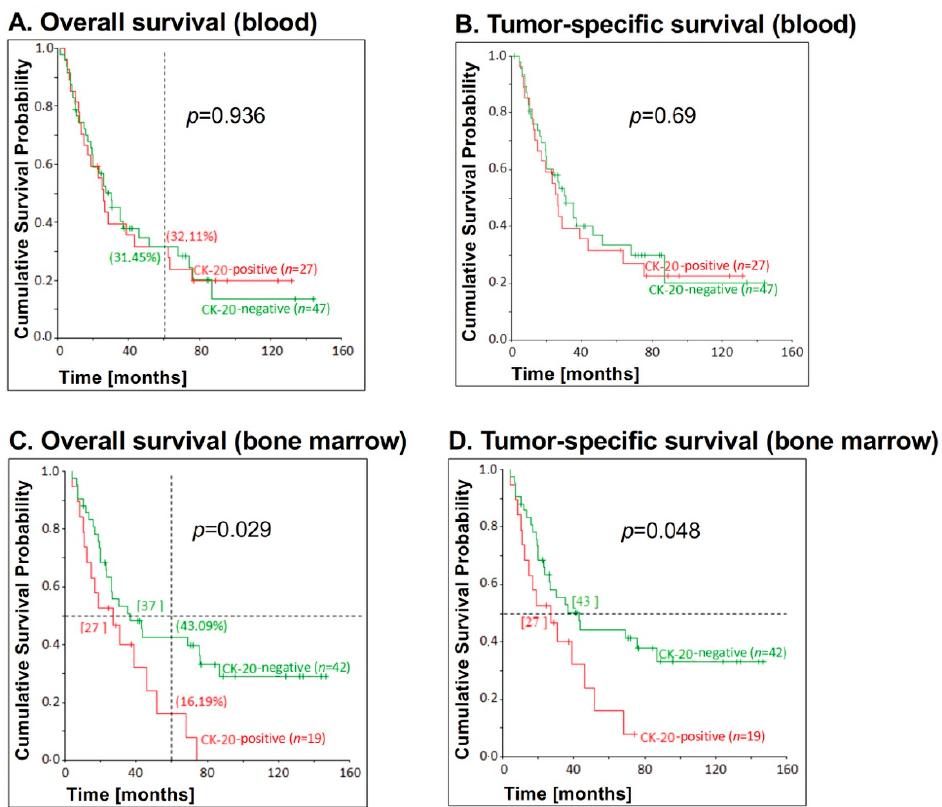
Figure 2. Correlation between CK20 positivity in blood and bone marrow samples, respectively, and survival for patients with esophageal carcinoma. CK20 positivity in ( A , B ) blood ( n = 27) and ( C , D ) bone marrow ( n = 19) samples of EC patients was assessed by reverse transcription-nested polymerase chain reaction (RT-PCR) and correlated with ( A , C ) overall survival and ( B , D ) tumor-specific survival. On the vertical dotted line at 60 months, the percentages of 5-year overall survival are shown in brackets. The p -values for the comparison of the cumulative survival probabilities of the two groups (CK20-positive versus CK20-negative) were calculated using the log-rank test. The horizontal dotted line at the cumulative survival probability of 0.5 gives the median survival and is given in months in square brackets.